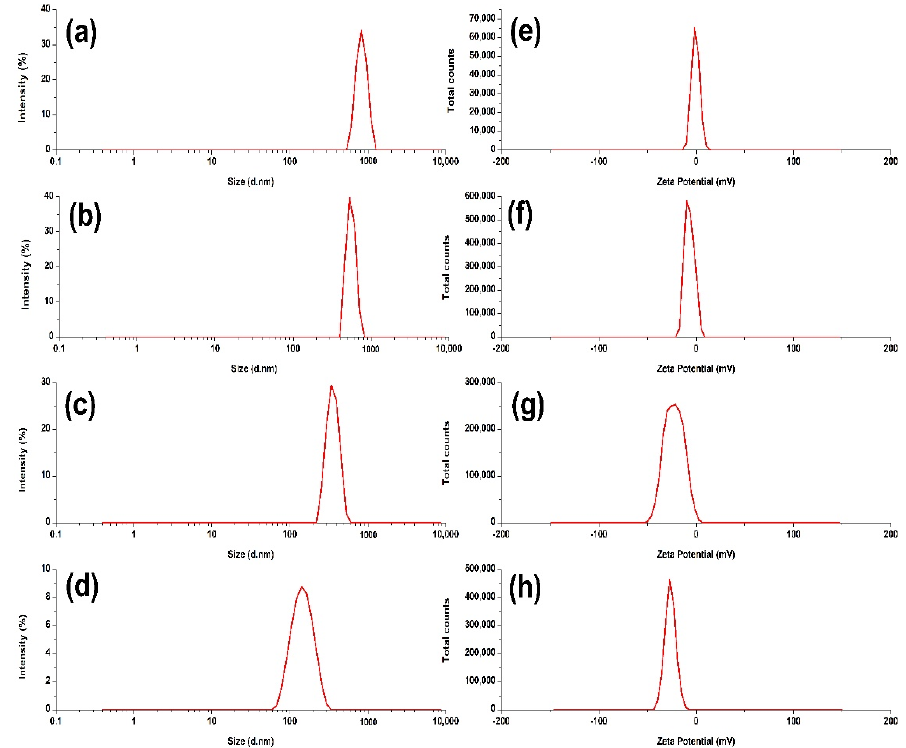
Figure 4. The size distributions of NCs − 1, NCs-2, NCs − 3 and the optimized NCs − 3 as NC 1 (( a – d ), respectively). Zeta potential distributions of NCs − 1, NCs − 2, NCs − 3 and the optimized NCs − 3 as NC 1 (( e – h ), respectively).